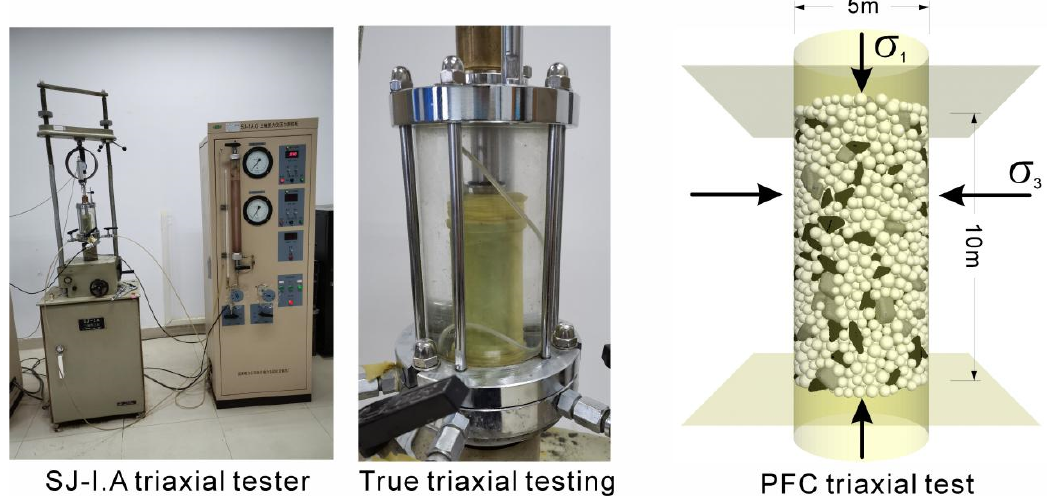
Figure 6. Schematic diagram of the triaxial test.